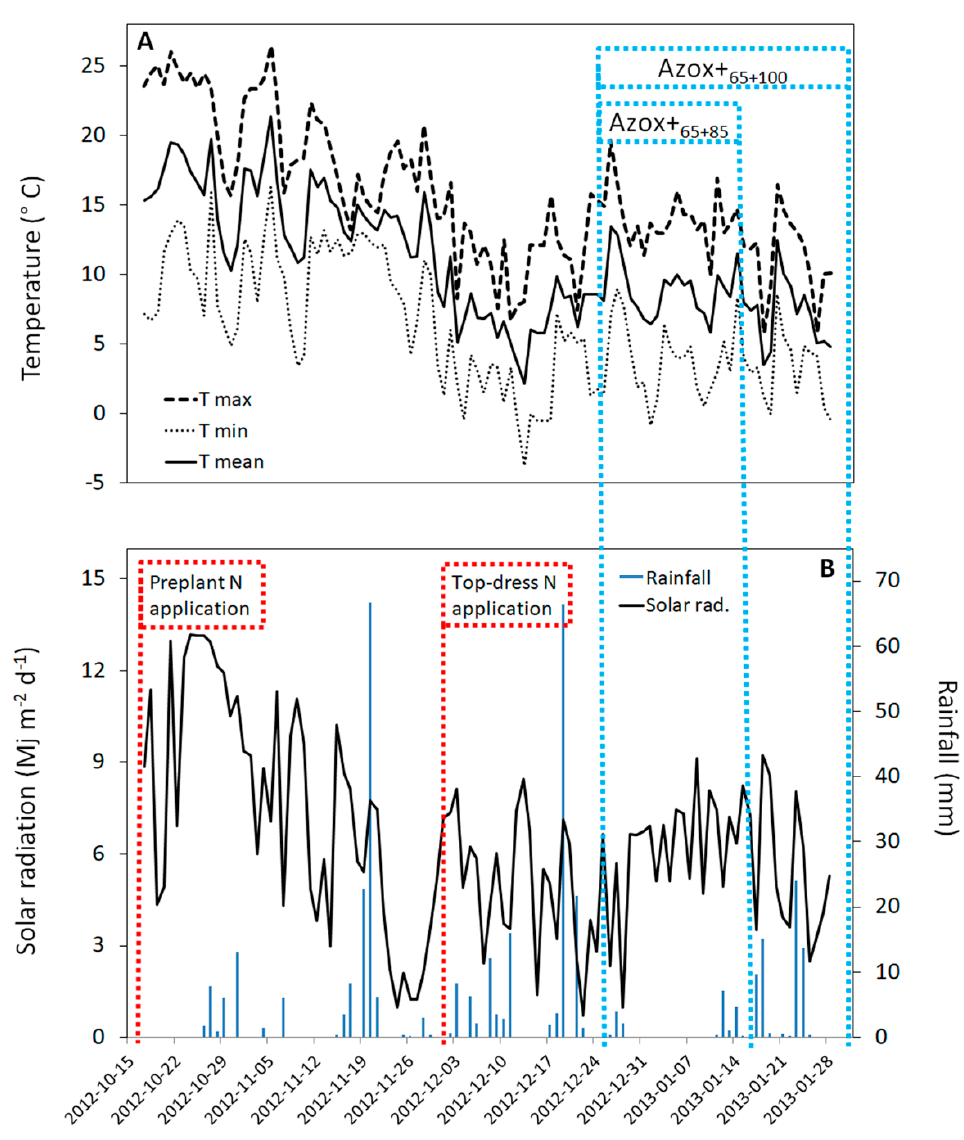
Figure 1. ( A ) The daily temperatures (the minimum, maximum, and average) during the lettuce crop cycle. The blue dotted lines indicate the dates of azoxystrobin application: Azox+ 65/85 and Azox+ 65/100 , respectively, application at 65 and 85 or 65 and 100 days after transplant (DAT). ( B ) The daily solar radiation and rain events during the lettuce crop cycle. The red dotted lines indicate the dates of the nitrogen application.